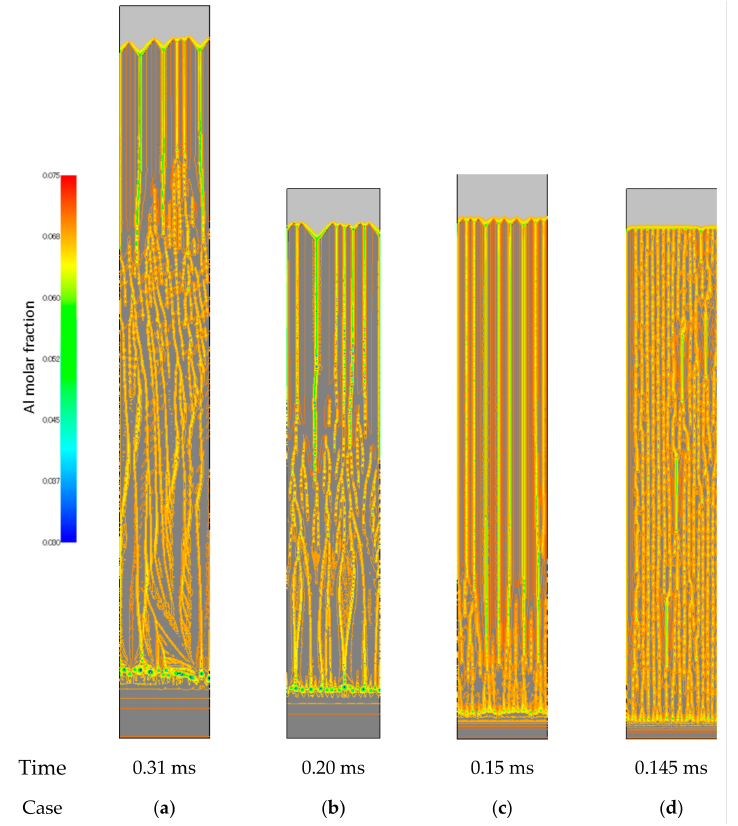
Figure 7. Snapshots of solidification microstructure distributions obtained by the quasi-equilibrium MPFM with Al concentrations (molar fraction) of ( a ) 5 × 10 5 K/s and 5 × 10 6 K/m, ( b ) 1 × 10 6 K/s and 1 × 10 7 K/m, ( c ) 5 × 10 6 K/s and 5 × 10 7 K/m and ( d ) 1 × 10 7 K/s and 1 × 10 8